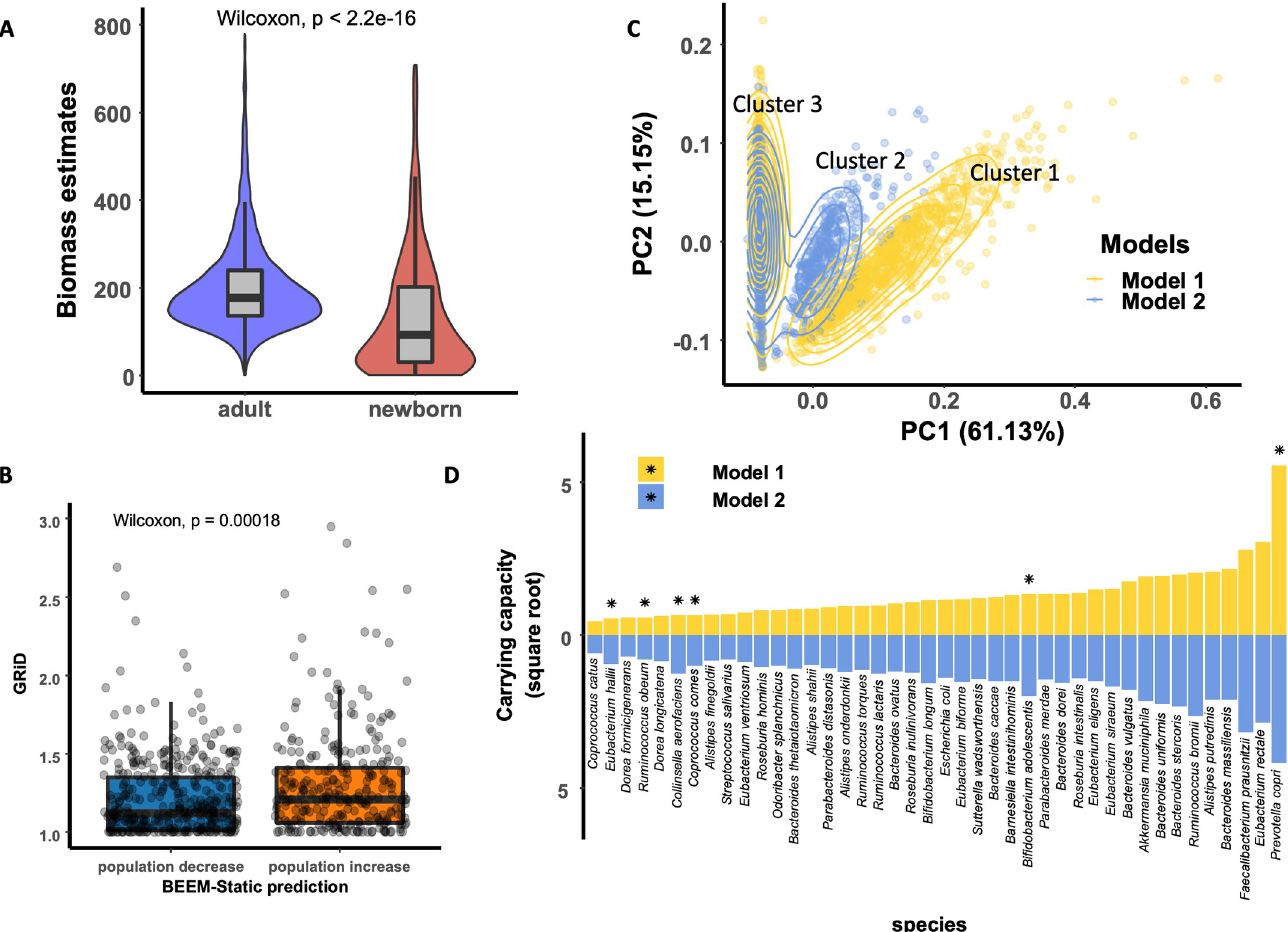
Fig 4. Analysis of human gut microbiomes with BEEM-Static. (A) Violin plots showing the significant difference in BEEM-Static biomass estimates for adults and newborn infants. (B) Boxplots showing differences in DNA replication rates (GRiD estimates) for species predicted to decrease and increase in population size, respectively, by BEEM-Static. Each point represents one species in a sample. (C) Scatter plot showing the first two components from a principal component analysis of equilibrium abundances for samples (as predicted by BEEM-Static). (D) Predicted carrying capacities (square root transformed) of species in the two models. Species with divergent carrying capacities (ratio is > 2 standard deviations from 1) in the two models are marked with stars.